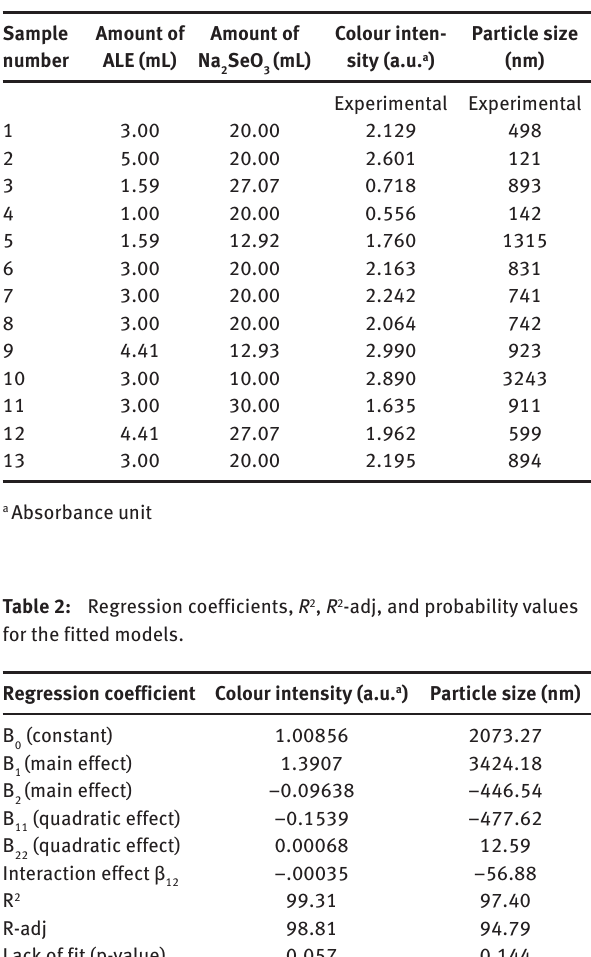
Table 1: Central composite design (CCD) and response variables for processing of synthesis Se NPs.